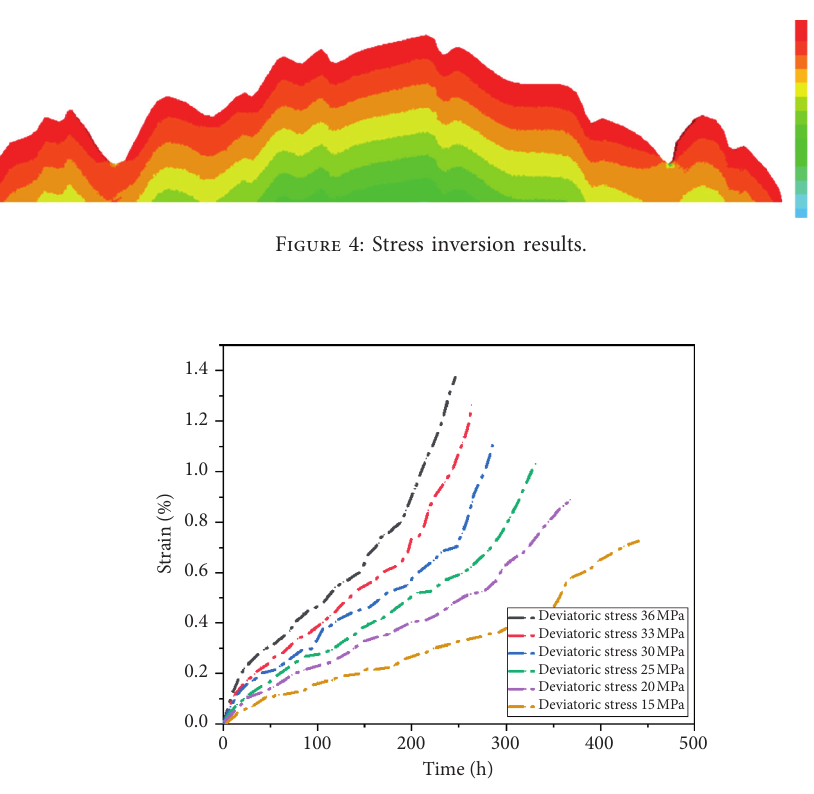
Figure 5: Creep test results of mudstone under different